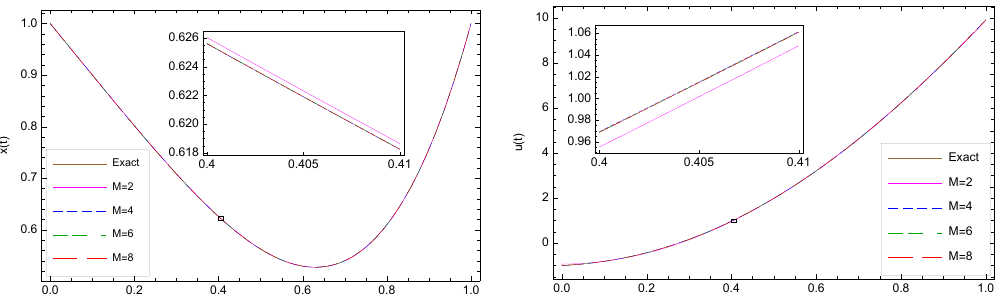
Figure 4. (Example 3.) Comparison between the exact and approximate state ( left ) and control ( right ) functions obtained by Approach I with M = 1.